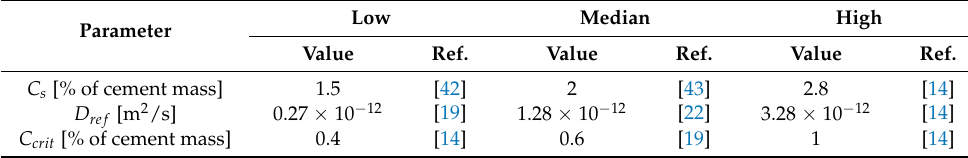
Table 3. Main chloride-induced corrosion governing parameters.